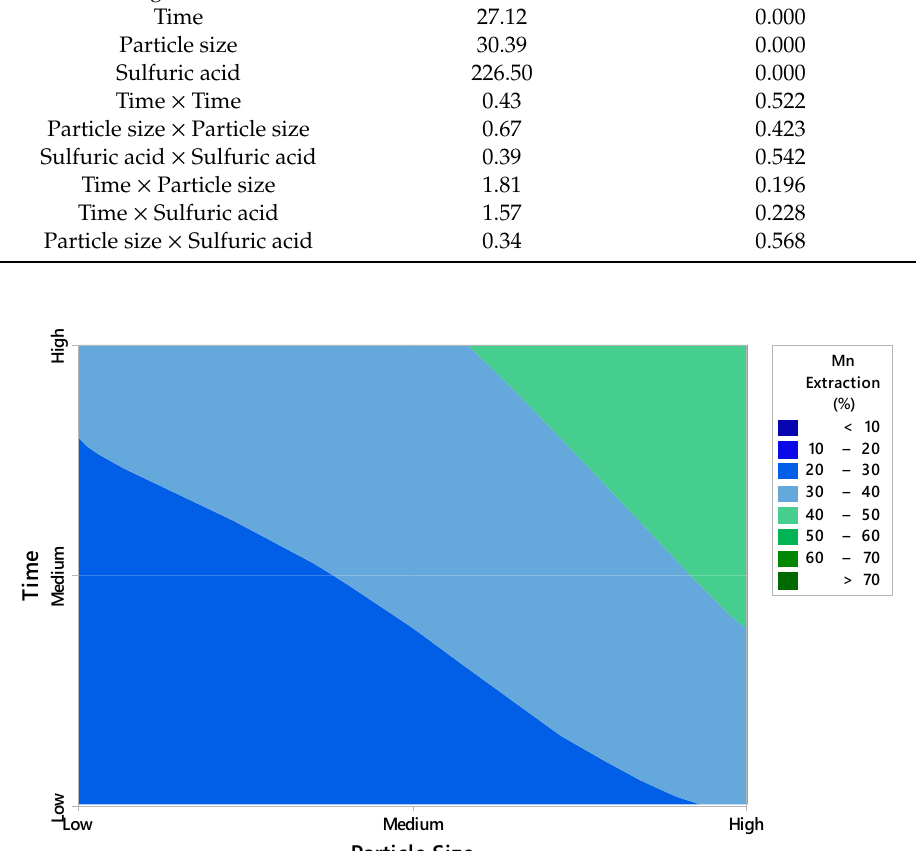
Figure 1. Experimental contour plot of Mn extraction (25 °C; − 150 + 106, − 75 + 53, − 47 + 38 μ m particle size; 10, 20, 30 min leaching time).